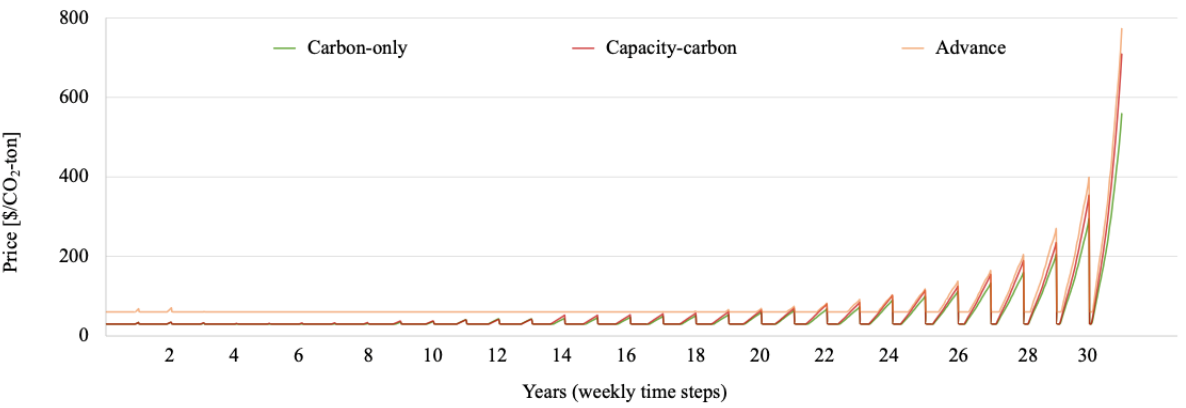
Figure 14. The changes in carbon price.